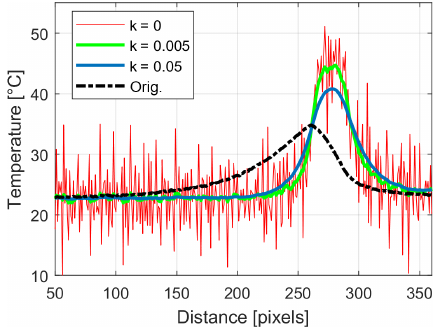
Figure 4. Amplification factor depending on the frequency due to deconvolution with the parametrized Wiener filter.